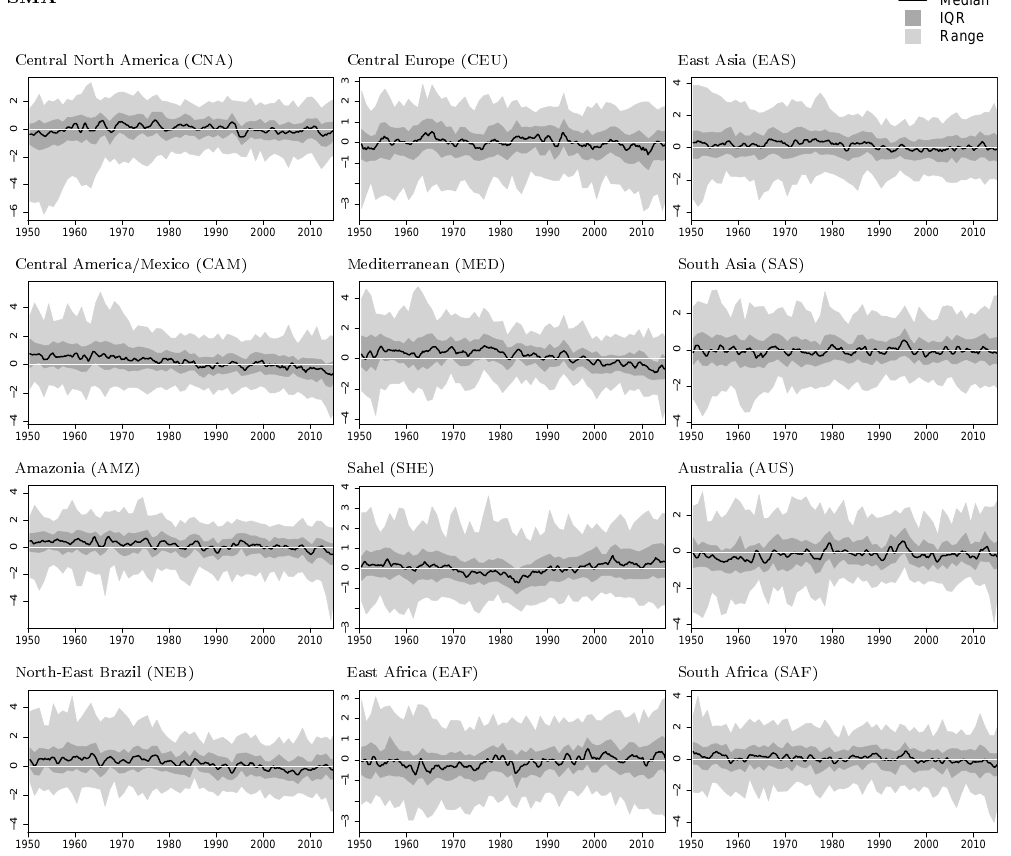
Fig. 5. CMIP5 simulated SMA: Median, inter-quartile range and total range across the CMIP5 ensemble of annual SMA averages (black line, dark grey and grey shading, respectively). Until 2005, CMIP5 data come from the historical simulations, after-wards, projections for the GHG concentrations scenario RCP8.5 are used. SMA values are calculated with respect to the 1979–2009 period for all